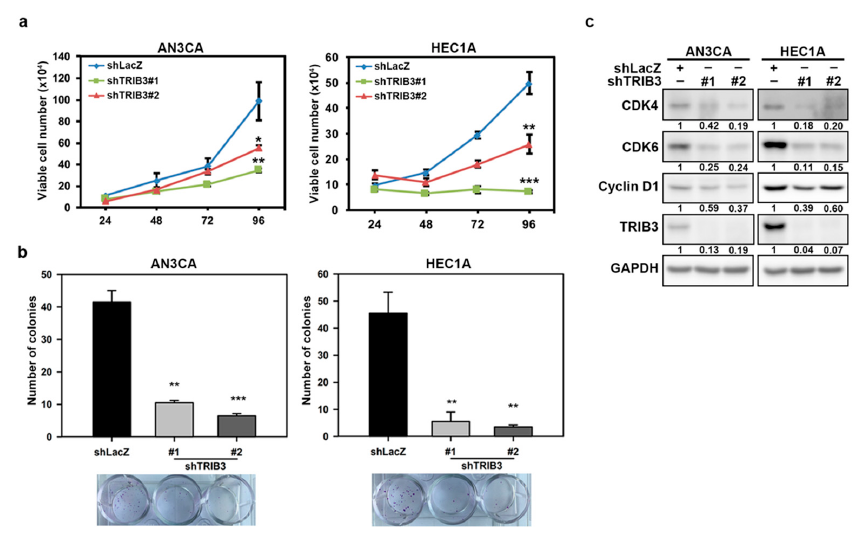
Figure 2. TRIB3 silencing decreased cell growth through the disruption of cyclin D1 and cyclin- dependent kinase (CDK) 4 / 6 expression. AN3CA or HEC1A cells were transduced with shLacZ or TRIB3-specific short hairpin RNAs (shRNAs) carrying lentiviruses and selected with 2 µ g / mL puromycin for 3 days. ( a ) The survived cells were then seeded into a 12-well plate at 1 × 10 4 cells / well and the cell number was counted with a trypan blue exclusion assay every 24 h. ( b ) The cells were seeded into a 12-well plate at 250 cells / well and incubated for 7 days. The cell colonies were visualized and counted after crystal violet staining. ( c ) Specific amounts (25 µ g) of total cellular proteins from AN3CA ( c left panel ) or HEC1A ( c right panel ) cells transduced with shRNA carrying lentiviruses were subjected to determine indicated proteins by Western blot analysis. * p < 0.05; ** p < 0.01; *** p <